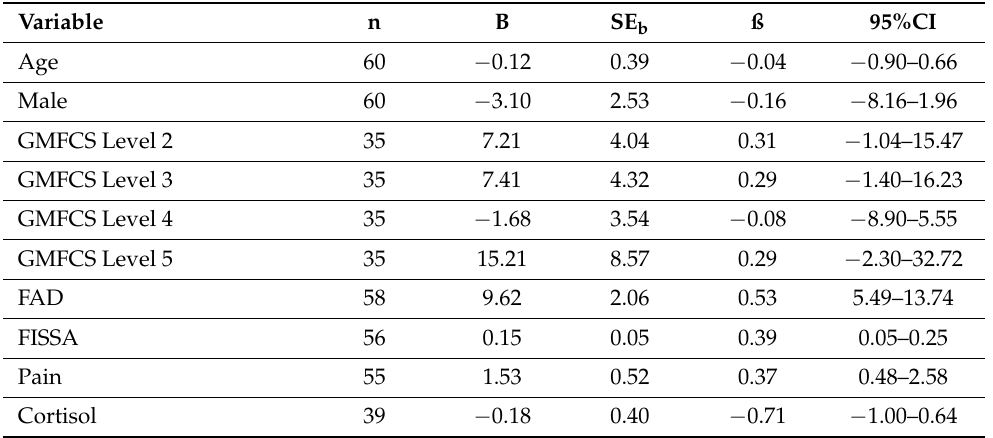
Table 4. Summary of regression models—predictors of CES-D